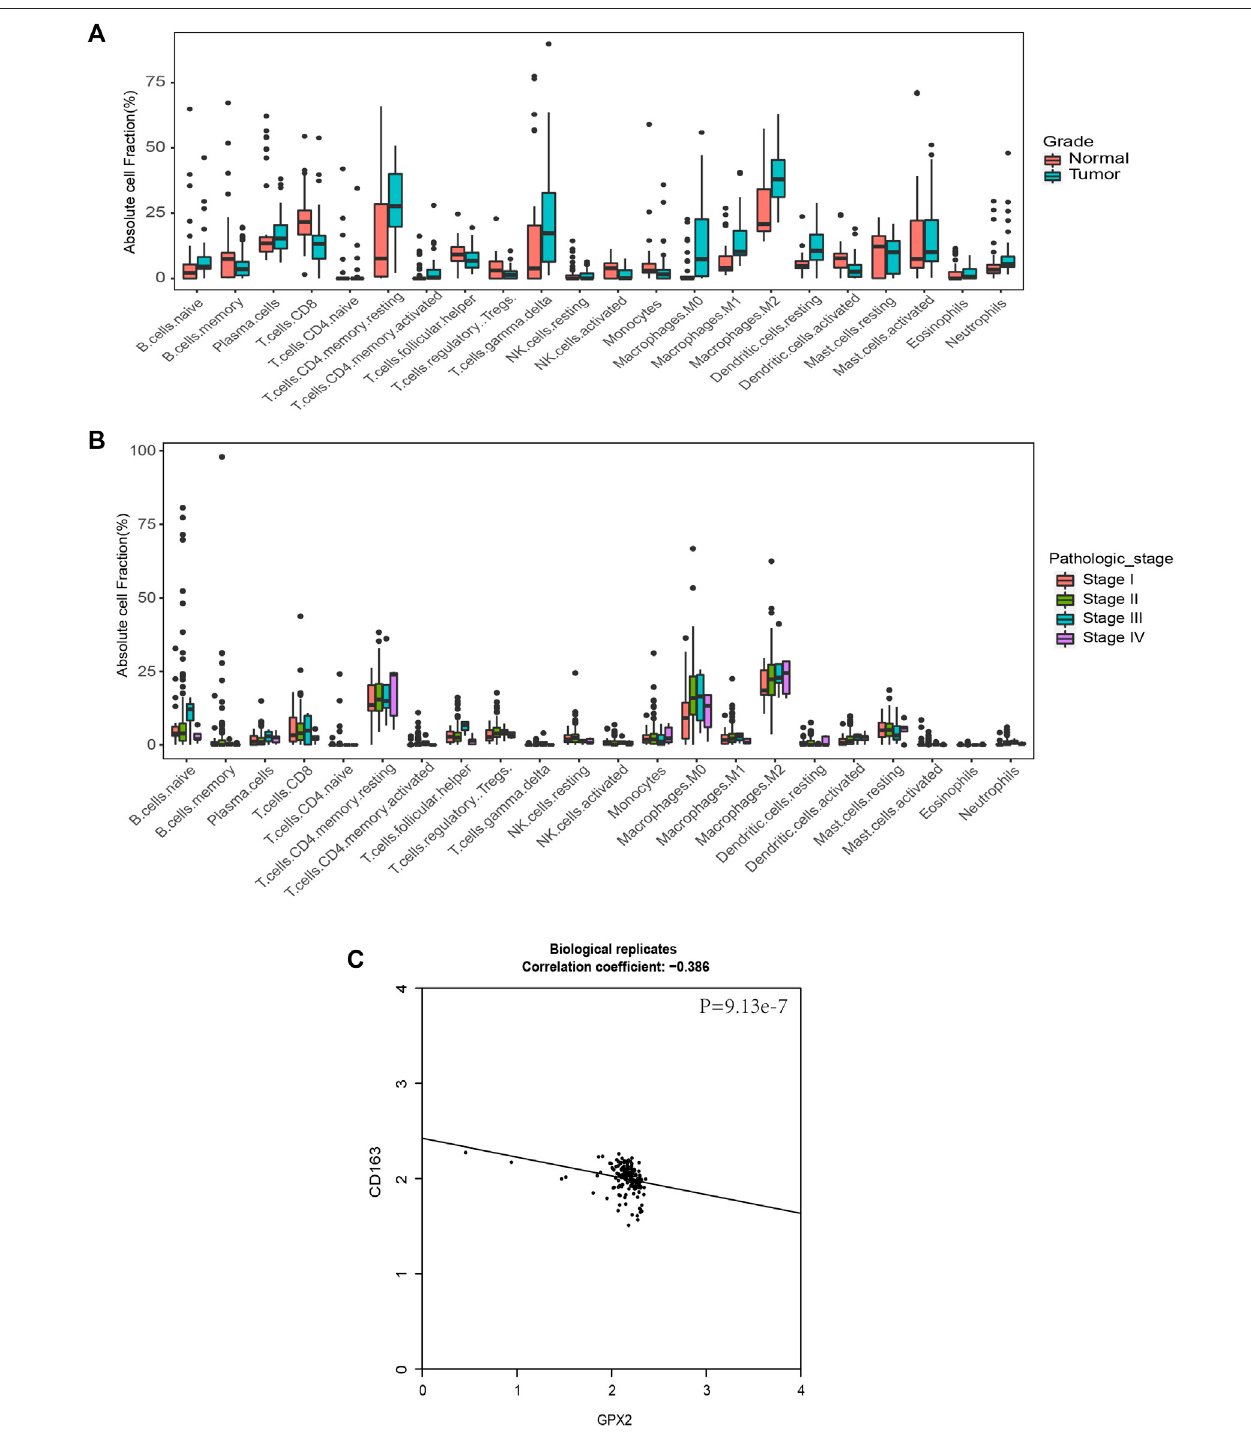
FIGURE 6 | GPX2 is associated with M2 macrophages, which predicts cancer immune heterogeneity. (A) Comparison of immune cell fractions among subtypes. Immune cell fraction distribution in 36 normal samples and 36 pancreatic cancer groups. (B) Comparison of immune cell fractions between subtypes. Among them, 21 samples in Stage I, 151 samples in Stage II, 4 samples in Stage III and 5 samples in Stage IV, with a simple row score > 0.05. (C) Scatter plots showing the correlation between GPX2 and CD163 .